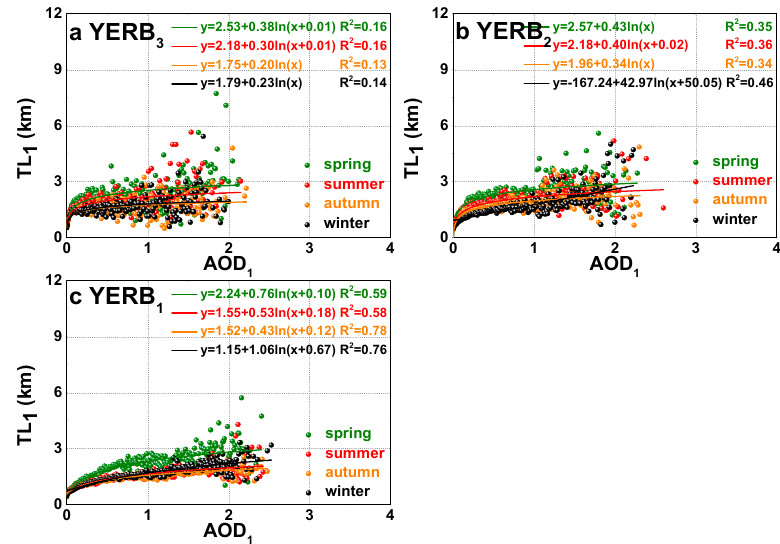
Figure 6. Correlation between AOD of the lowest aerosol layer (AOD 1 ) and thickness of the lowest aerosol layer (TL 1 ) over YERB. Where ( a ) is for YERB 3 , ( b ) is for YERB 2 , and ( c ) is for YERB 1 .